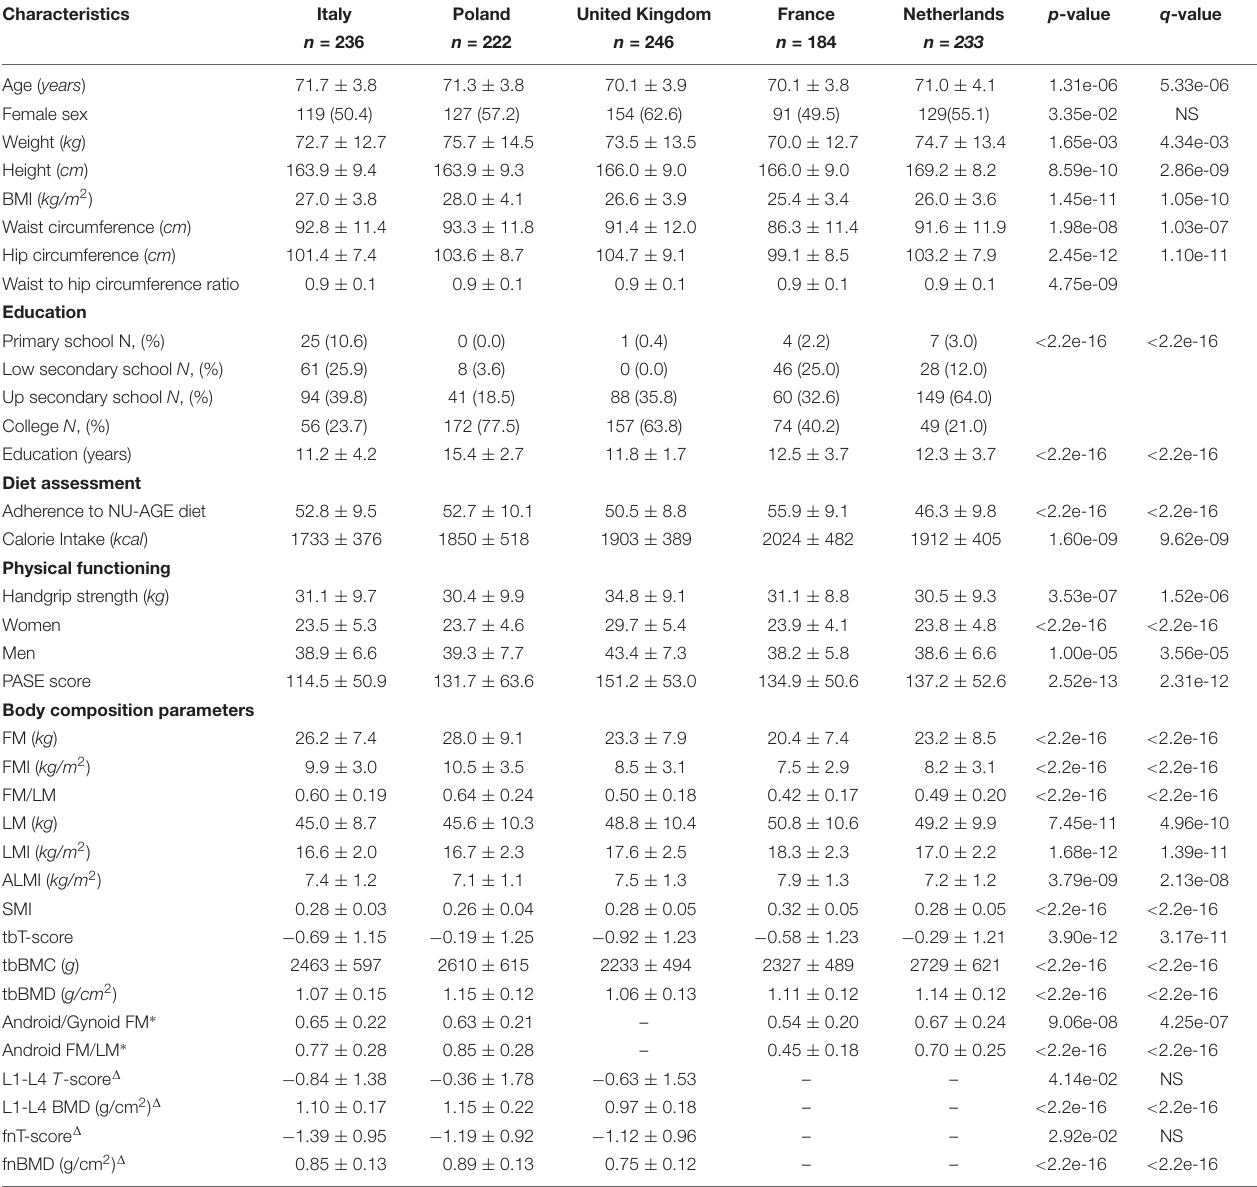
TABLE 2 | Characteristics of the NU-AGE participants by country of origin ( N = 1,121).